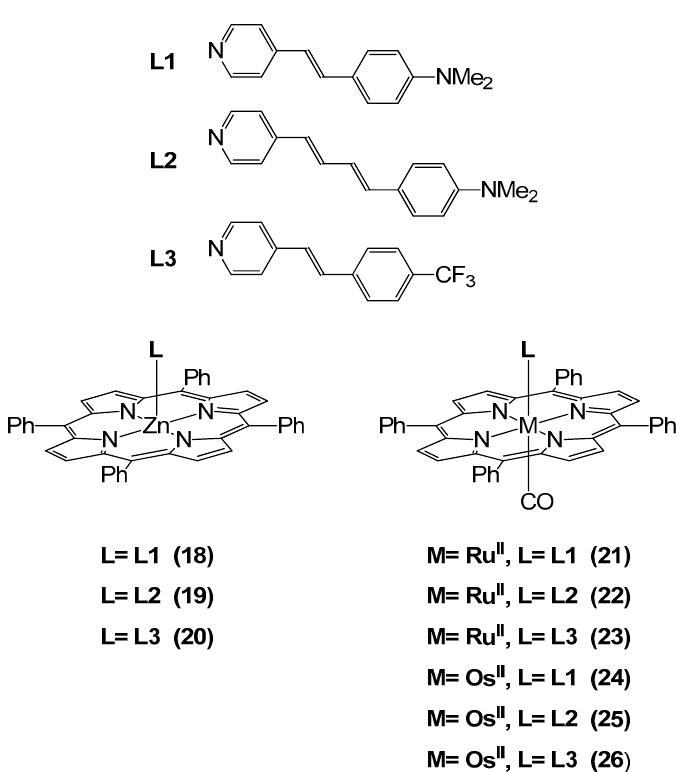
Figure 3. Metal porphyrins axially substituted with donor or acceptor E -stilbazoles. Adapted from Inorg. Chim. Acta 2006 , 359 , 3029 − 3041.